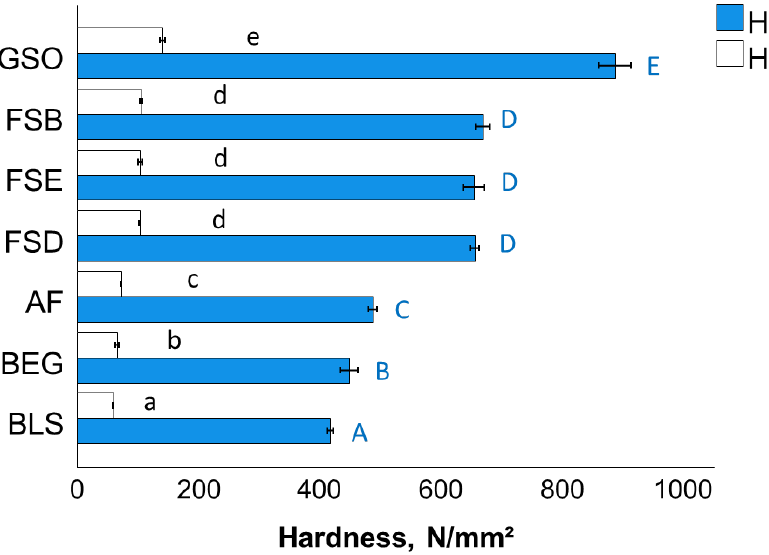
Figure 8. Martens (HM) and Vickers hardness (HV) as a function of RBC (mean values with 95% confidence interval; capital and small letters indicate statistically homogeneous subgroups; Tukey’s HSD test, α = 0.05). Material abbreviation: AF = Admira Fusion; BEG = Brilliant EverGlow; BLS = Beautifil II LS; FSB = Filtek Supreme XTE Body; FSD = Filtek Supreme XTE Dentin; FSE = Filtek Supreme XTE Enamel; GSO = Grandio SO.